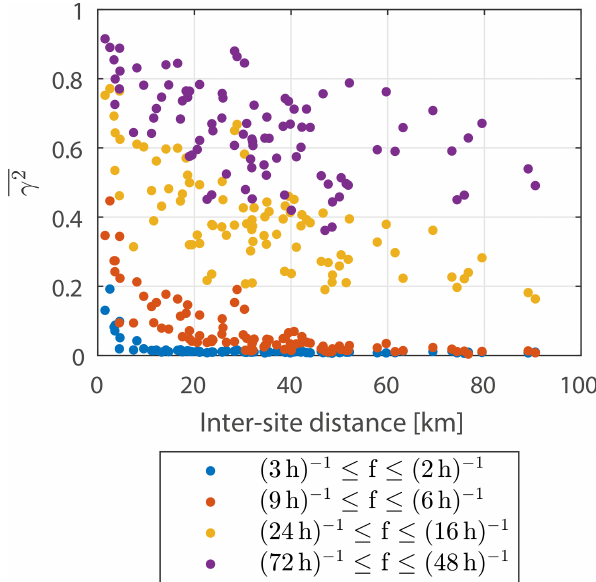
Figure 11. Average squared coherence for frequencies between (3h) − 1 and (2h) − 1 (blue color), (9h) − 1 and (6h) − 1 (red color), (24h) − 1 and (16h) − 1 (yellow color), and (72h) − 1 and (48h) − 1 (purple color) with respect to inter-site distance for all site pairs considered in Fig. 10. The considered frequency ranges are marked in Fig.